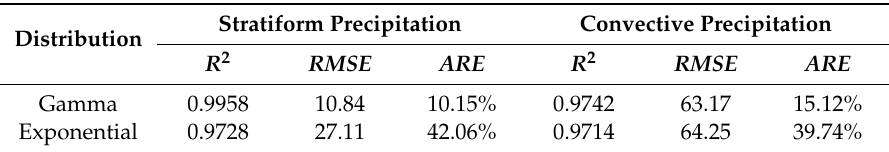
Table 2. Values of the statistical fit and